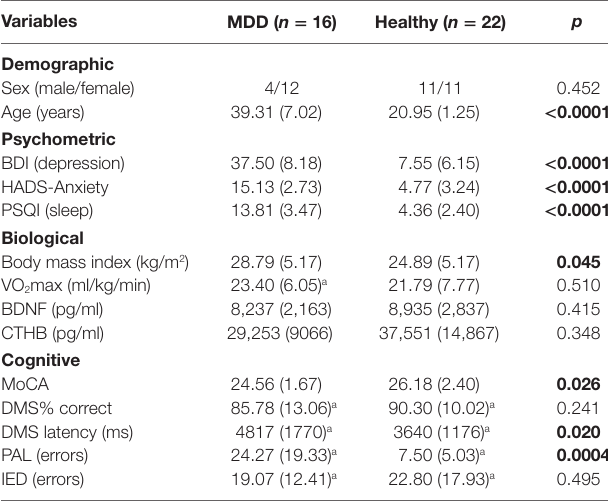
TaBle 1 | Baseline characteristics of depressed patients and healthy